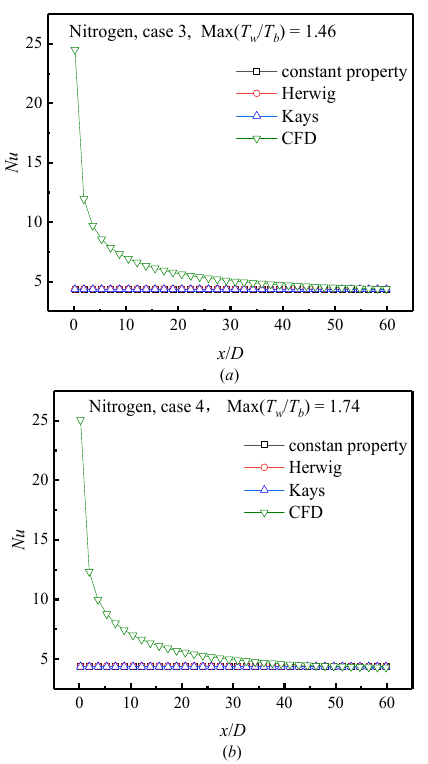
Figure 7. Calculations by existing Nu correlations for nitrogen. ( a ) case 3; ( b ) case 4. Table 7. Calculation errors of helium by Nu number correlations with case 1.